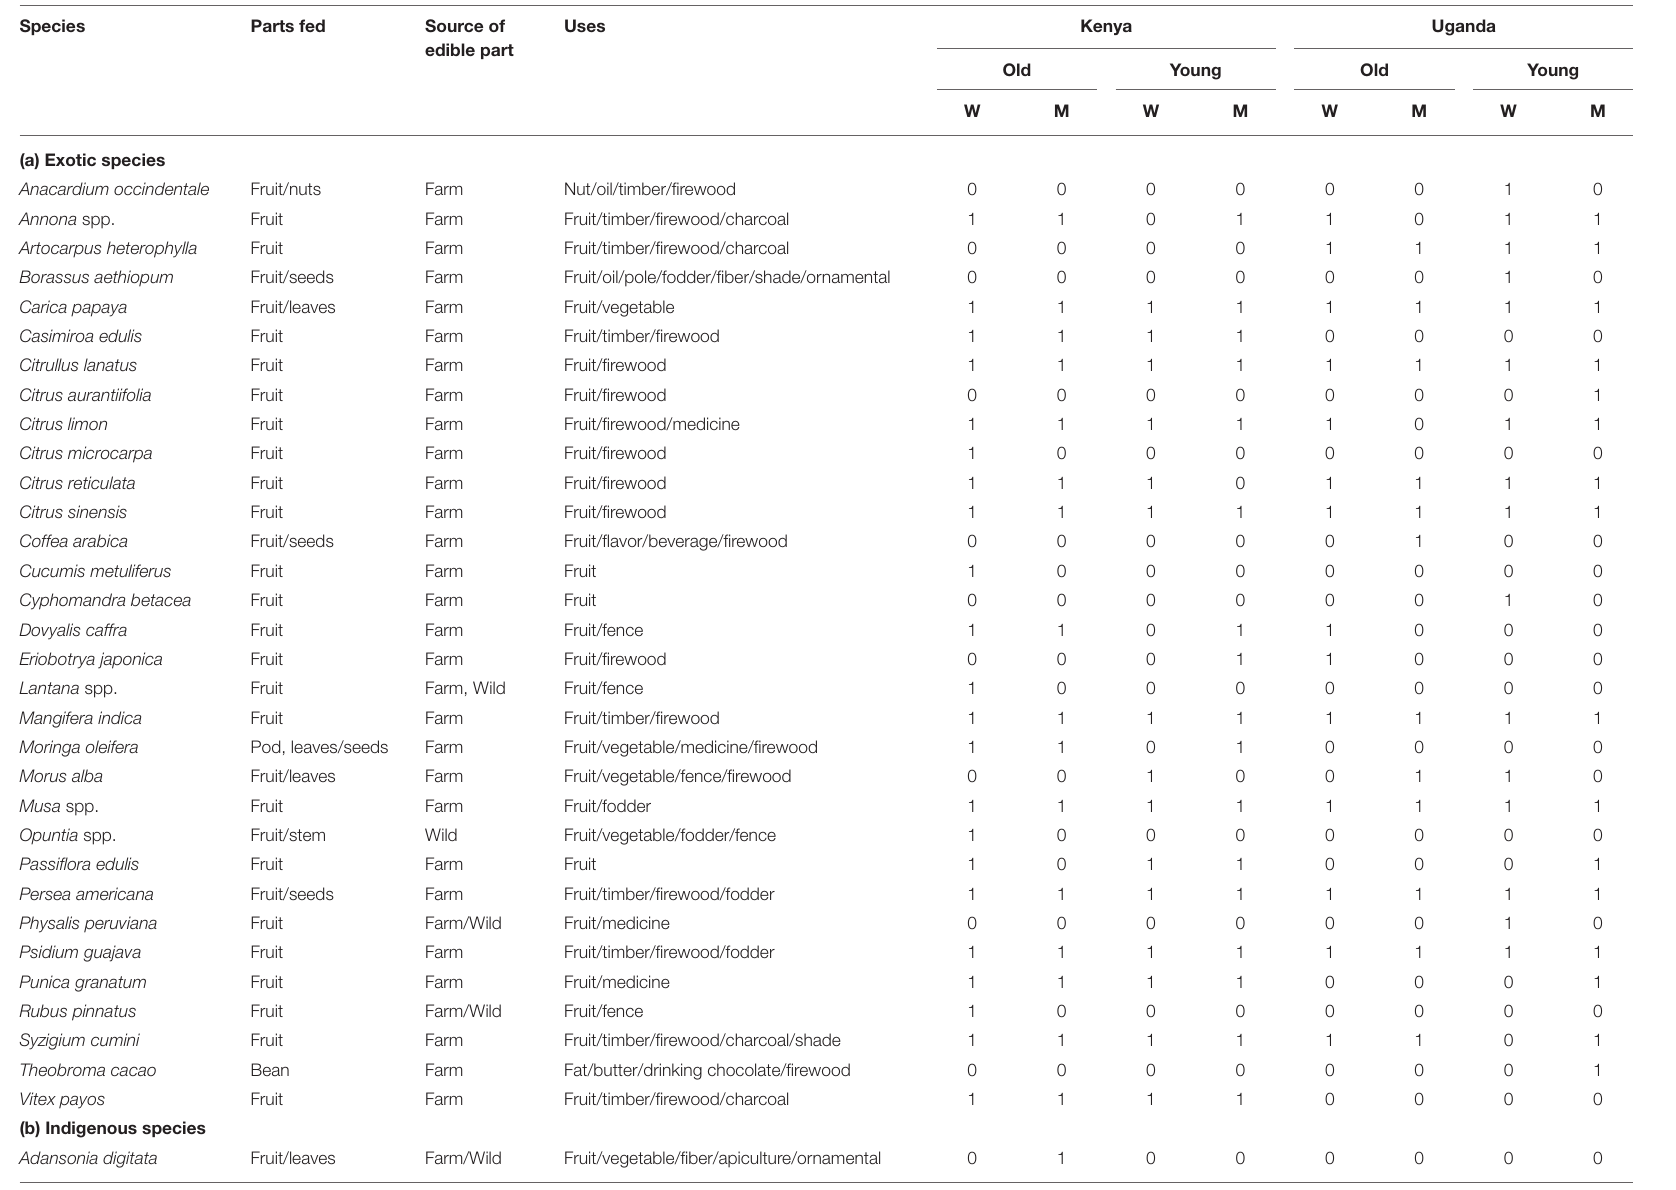
TABLE 1 | List of 61 food trees, shrubs, and other perennials (32 indigenous and 29 exotics) used as sources of food, fuelwood, fodders, and other uses by men and women interviewed in Kenya and